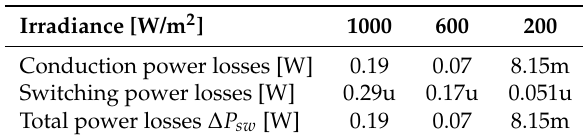
Table 6. Calculated switches power losses for different irradiance values, SPC-FOCV. Switching frequency is 1